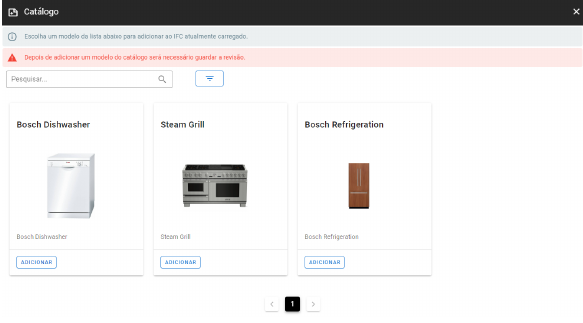
Figure 6. Editor Catalog interface.